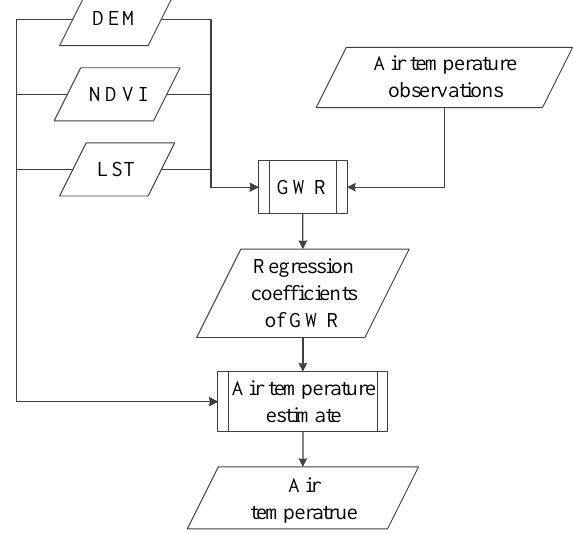
Figure 1 The flow chart of method for mapping near surface air temperature proposed in this